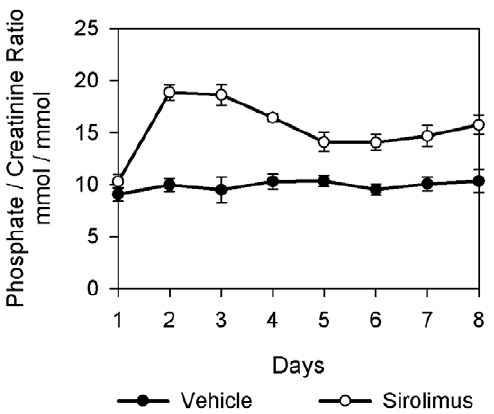
Figure 1. Effect of sirolimus on renal phosphate excretion. Trajectories of urinary phosphate/creatinine ratios of sirolimus and vehicle treated rats. Sirolimus caused statistically significant increased urinary phosphate excretion 24 hours after the first sirolimus injection (day 2) until after seven sirolimus injection (day 8, n=6 for each group).